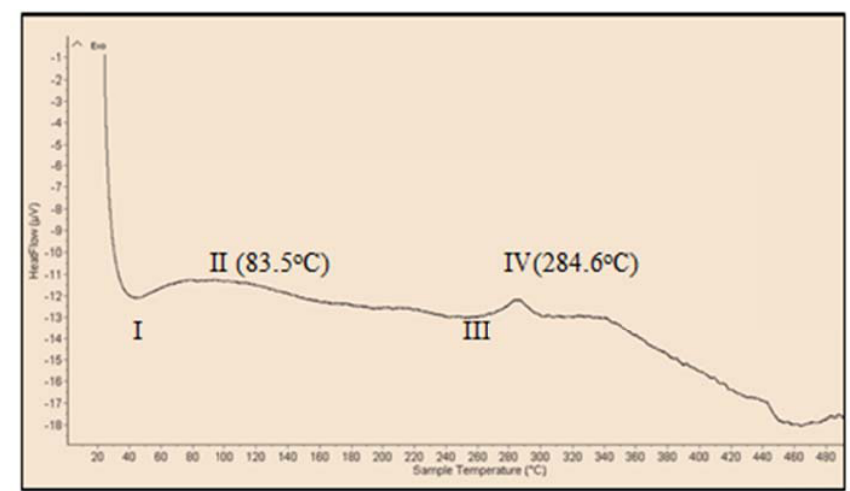
Fig. 8: DSC C analysis of f untreated A Al-Ti/1%SiC C